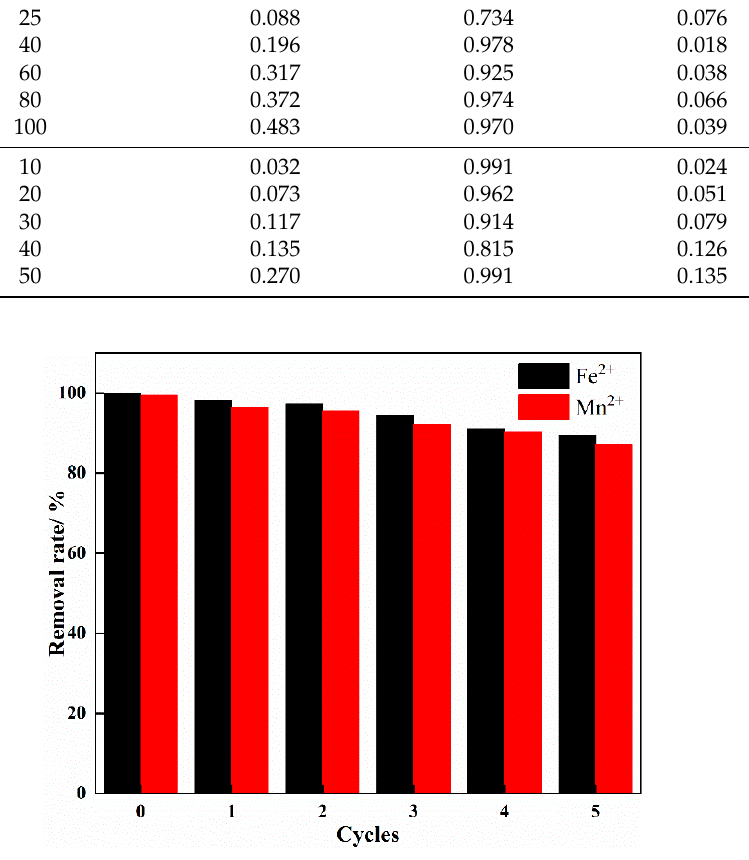
Table 5. Comparison of the IHA/TM composite adsorbent with previously reported adsorbents for the removal of iron and manganese in terms of uptake capacity.